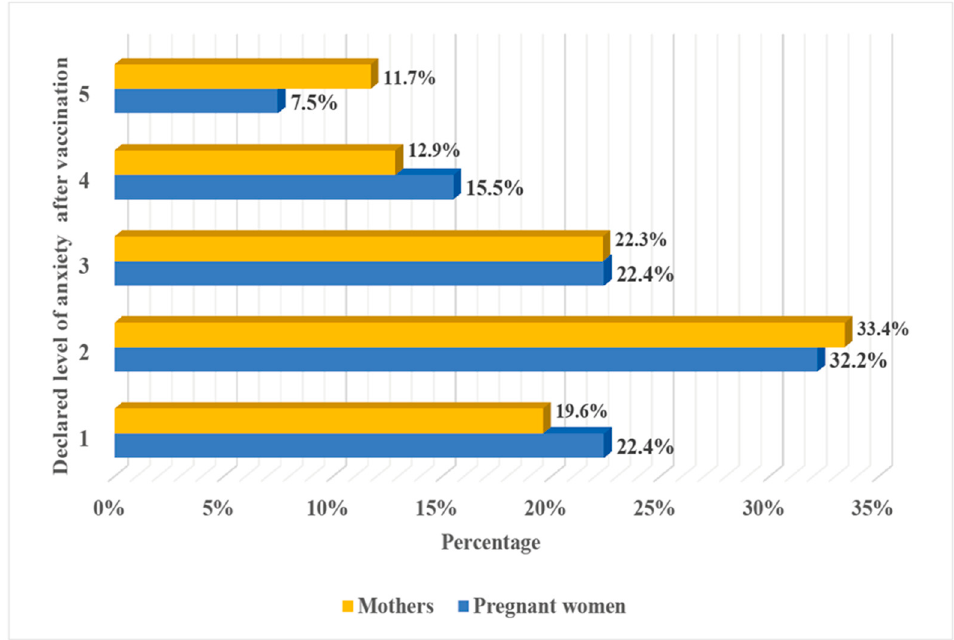
Figure 3. Declared level of anxiety of women after COVID ‐ 19 vaccination. Definitely not afraid—1 point on a five ‐ point scale of fear. Definitely afraid—5 points on a five ‐ point scale of fear.